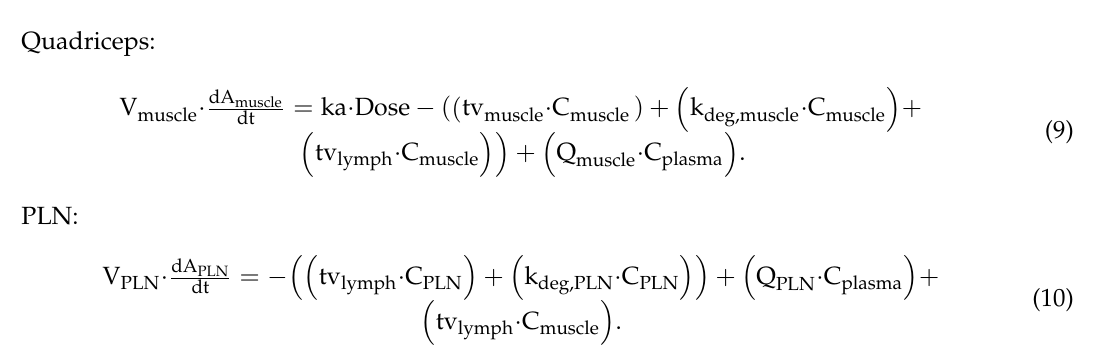
Figure 4. A bi-exponential model of in-vitro antigen stability.